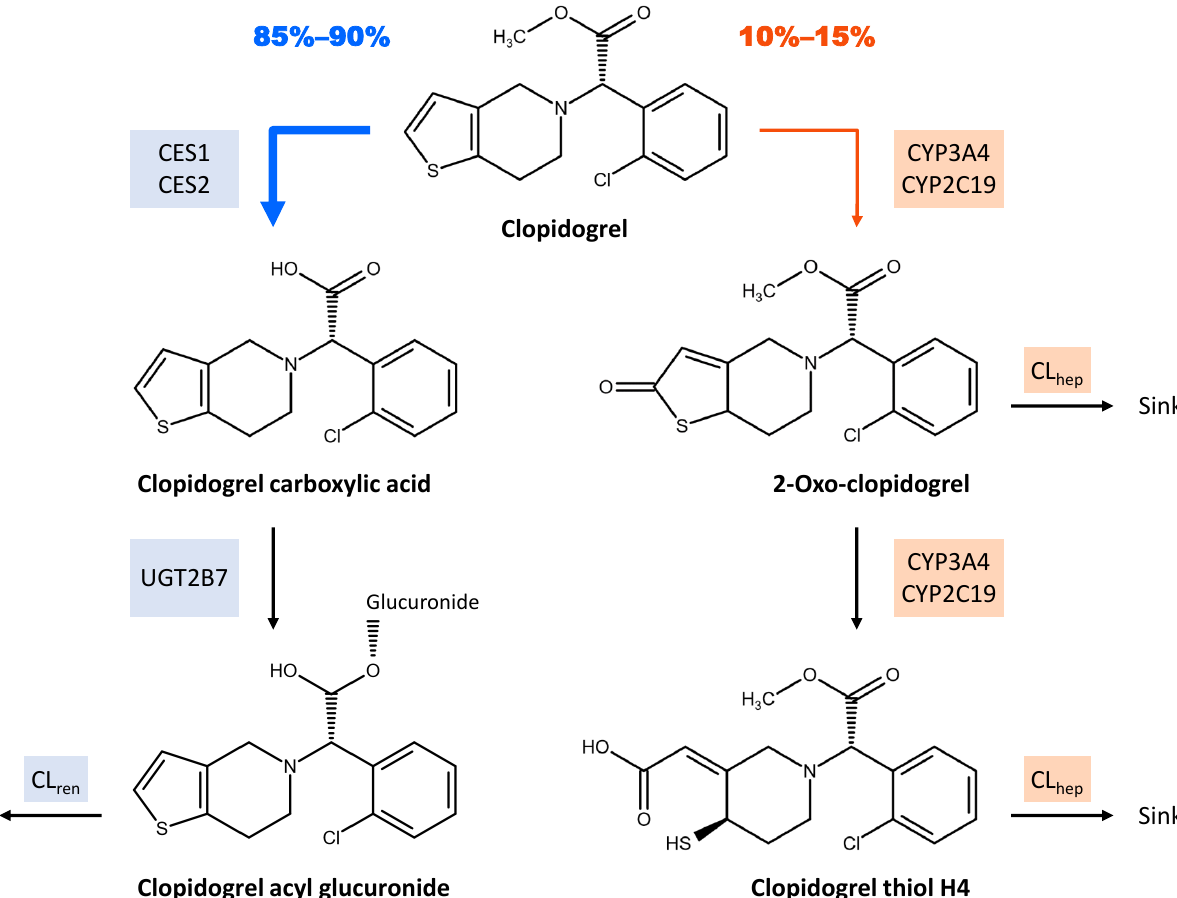
Figure 1. Clopidogrel’s main metabolic pathways and excretion processes implemented in PK-Sim ® . In total, 85–90% of the absorbed dose is converted via CES1 and CES2 into clopidogrel carboxylic acid, which undergoes further metabolism to clopidogrel acyl glucuronide via UGT2B7, with the latter being excreted via a nonspecific renal clearance. The remainder of clopidogrel absorbed is transformed via CYP3A4 and CYP2C19 into 2-oxo-clopidogrel with subsequent metabolization to the active metabolite clopidogrel thiol H4, both metabolites being excreted via nonspecific hepatic clearances. CES: carboxylesterase, CL hep : hepatic clearance, CL ren : renal clearance, CYP: cytochrome P450, UGT: uridine 5 (cid:48) -diphospho-glucuronosyltransferase. Metabolism and excretion steps are represented by